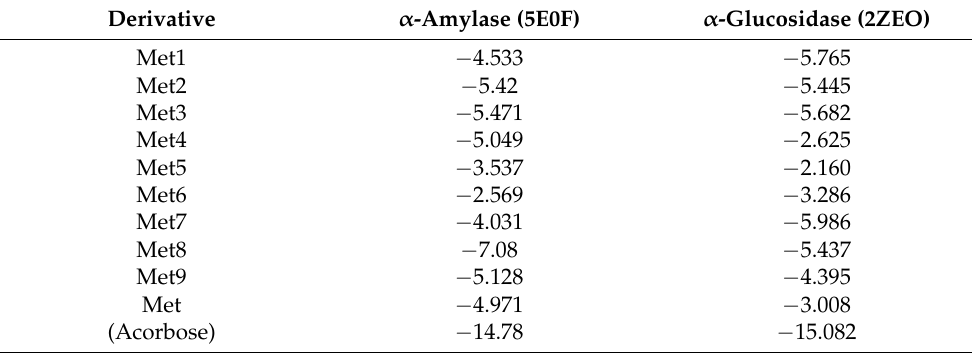
Figure 8. Induced fit docking study of the best pose generated on α -glucosidase: ( A ) MCu1 ligand-binding site; ( B ) MCu2 ligand-binding site; ( C ) MCu3 ligand-binding site; ( D ) MCu8 ligand-binding site. Table 10. Docking scores of metformin derivatives.